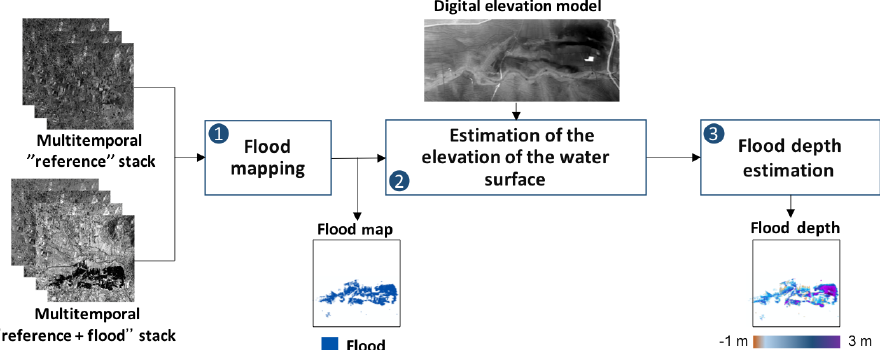
Figure 1. Flood depth estimation methodology: (1) flood maps are derived using the methodology presented in Cian et al. (2018); (2) by means of a high-resolution digital elevation model the elevation of the water surface is estimated, through a statistical analysis of elevation values along the boundary line of each flooded area; (3) flood depth is computed by subtracting the elevation values from the estimated elevation of water